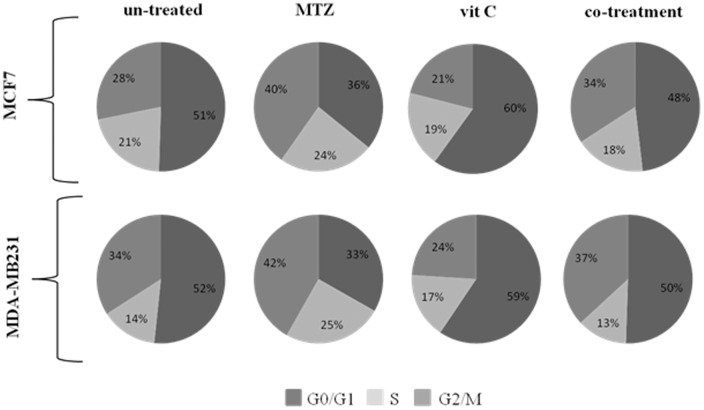
Cell percentages in G0/G1, S and G2/M phases in MCF7 and in MDA-MB231 cells.